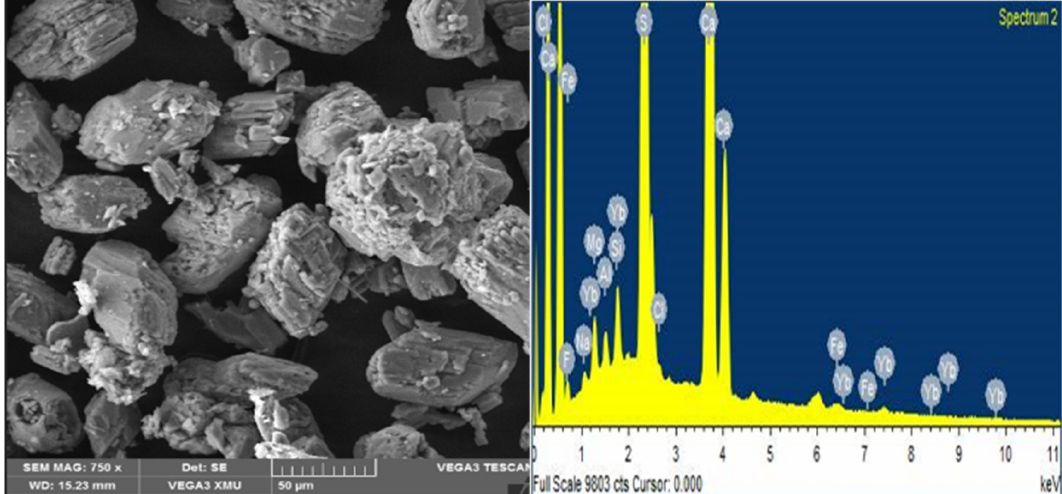
Figure 3. SEM and EDS analysis of raw WFGD gypsum.